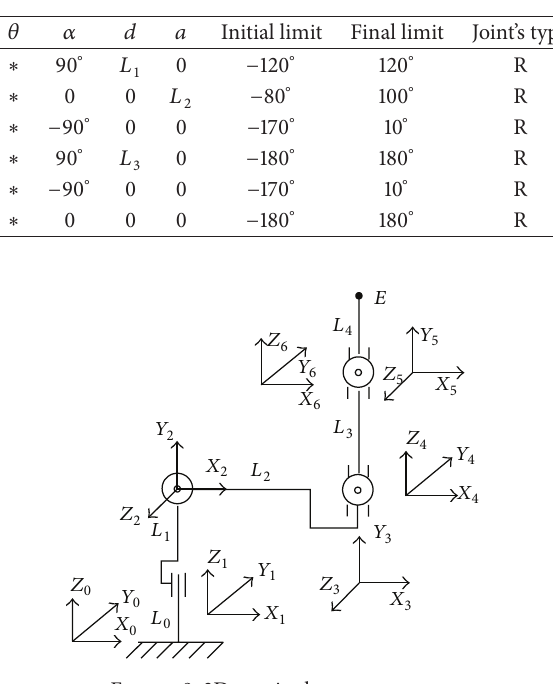
Table 1: DH parameters of manipulator.